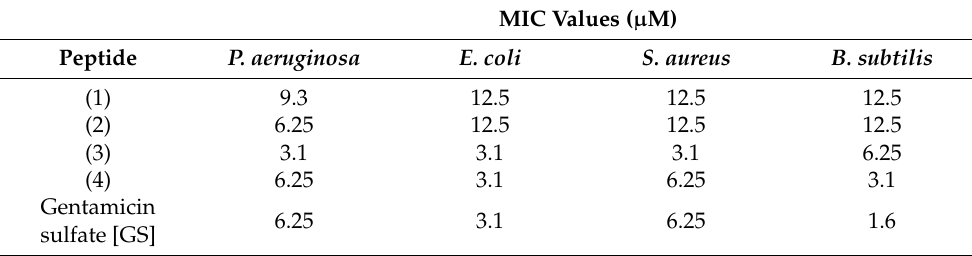
Figure 2. The 3D global minimum conformation of the ribbon-structures of the newly synthesized AMPs computationally predicted using MOE 18.0. Table 1. MIC values of the novel undecapeptides against Gram-negative and Gram-positive